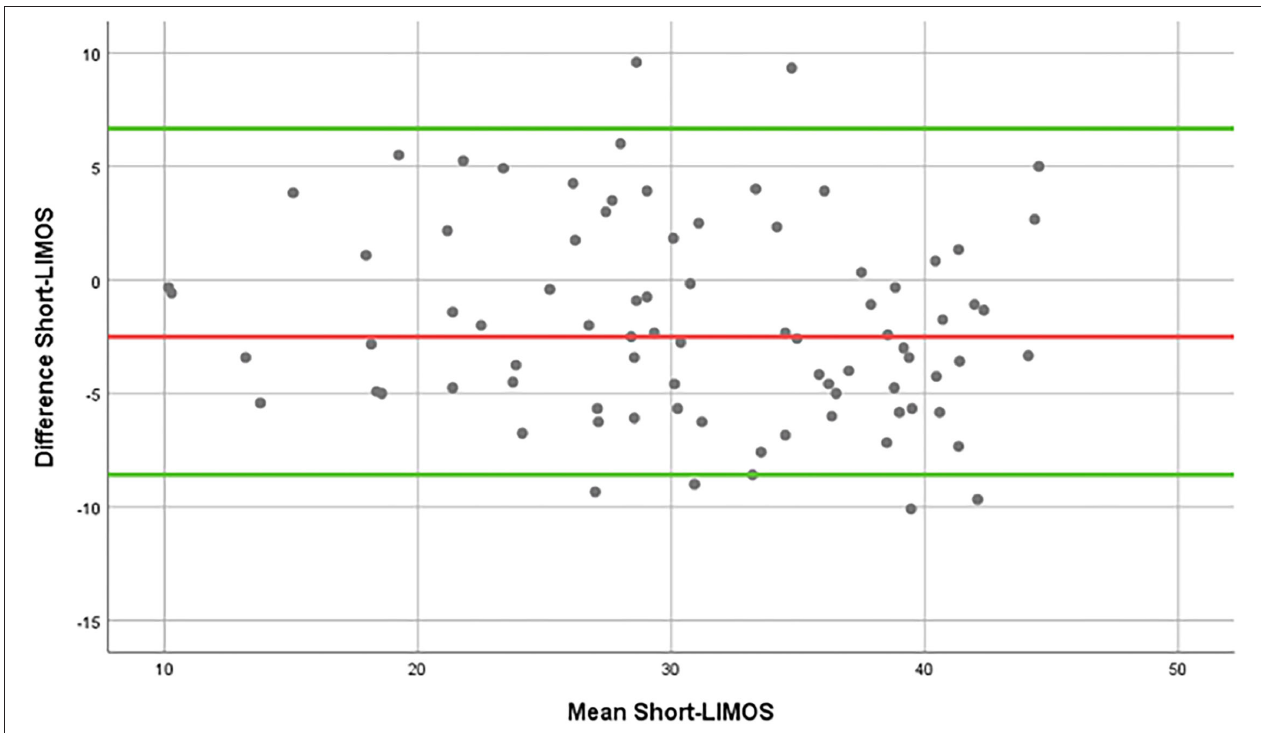
FIGURE 3 | Bland-Altman plot of the